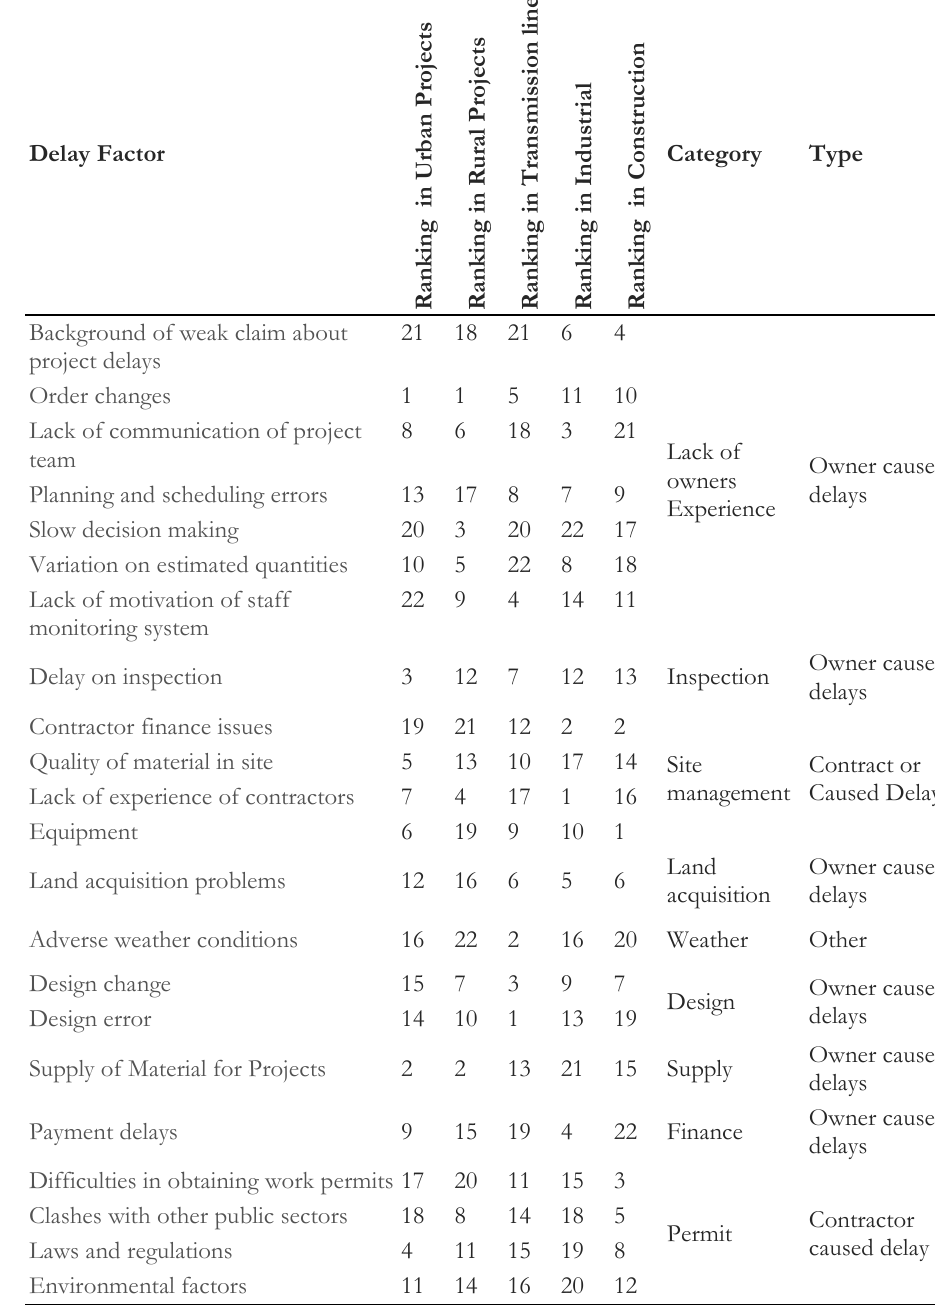
Table 2. Delay factors and ranking and categorizing